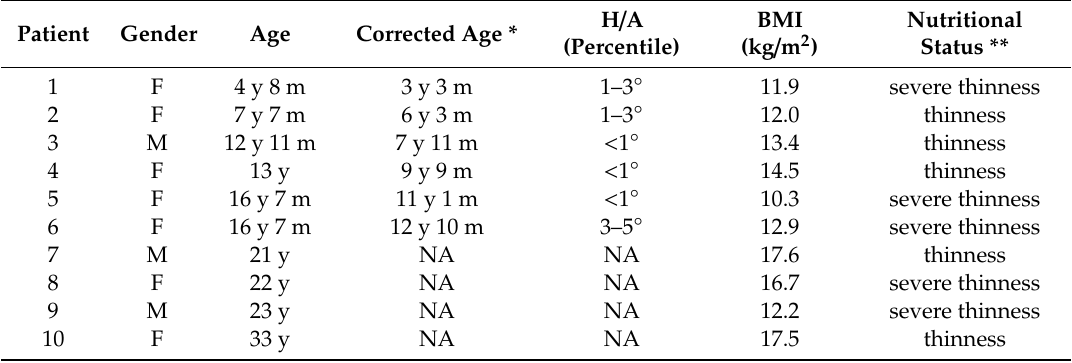
Table 2. Sociodemographic characteristics, growth, and nutritional status of subjects with recessive dystrophic epidermolysis bullosa.